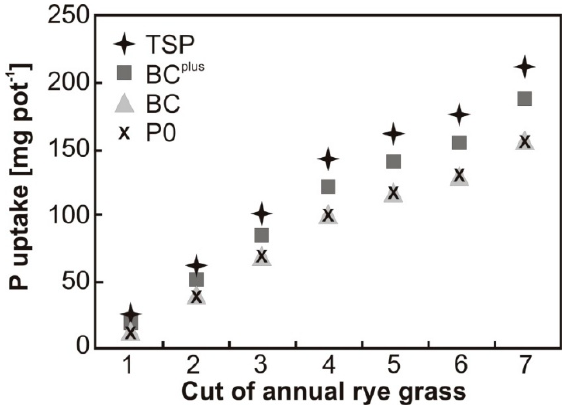
Figure 3. Cumulative P uptake of annual rye grass across all incubation times (mean of all incubation treatments from zero to eight weeks).